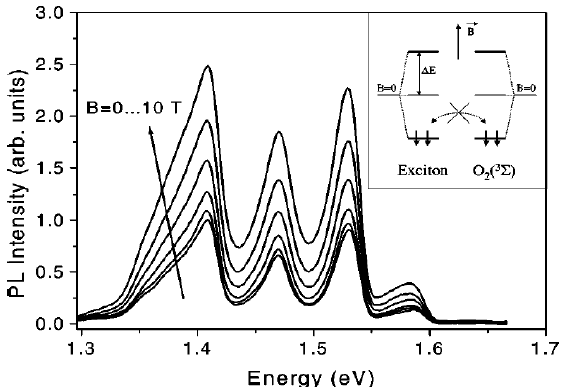
Figure 24. PL spectra of por-Si with adsorbed O 2 molecules at various strength of magnetic field at T = 10 K. The magnetic-field increment is equal to 2 T. Inset: Sketch of the Zeeman splitting of the triplet states of excitons in nc-Si and the ground state 3 Σ of O 2 . The spin orientation for electrons in the lowest-lying levels are indicated by arrows. (From Reference [65]).